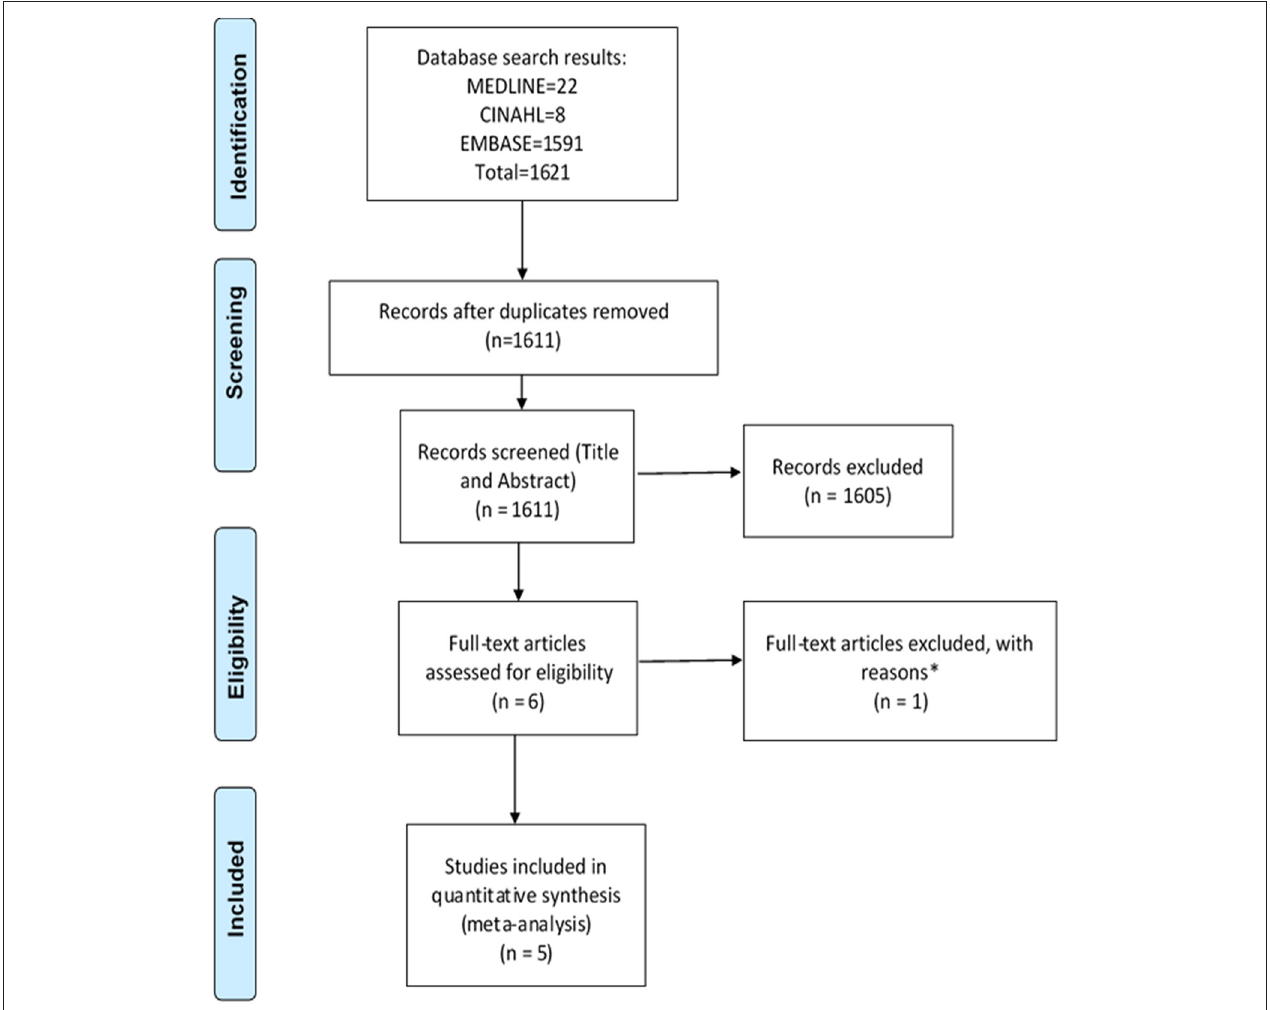
FIGURE 1 | PRISMA flow diagram of literature search and included studies on hospital admissions. Adapted from Liberati et al. (2009). *Excluded studies with reasons can be found in Table 1 .